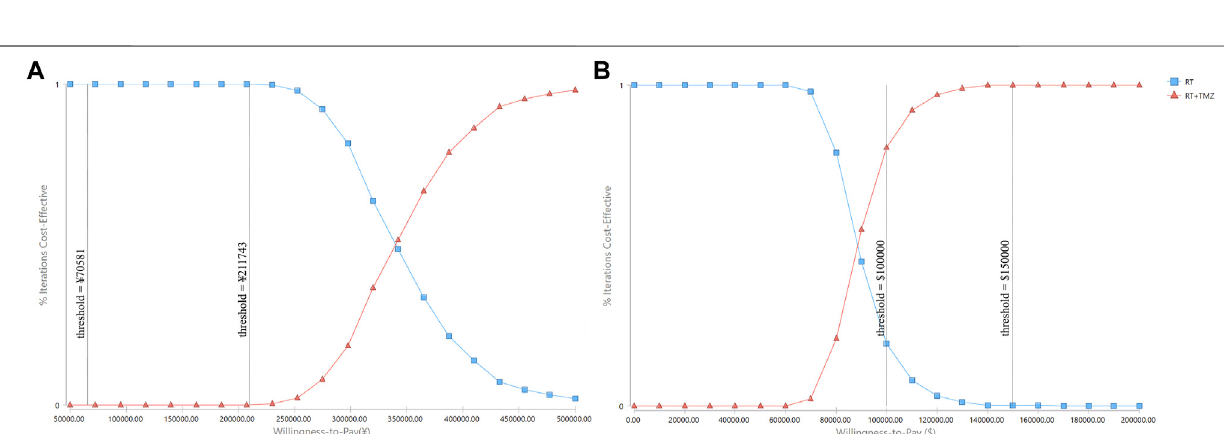
Frontiers in Pharmacology |